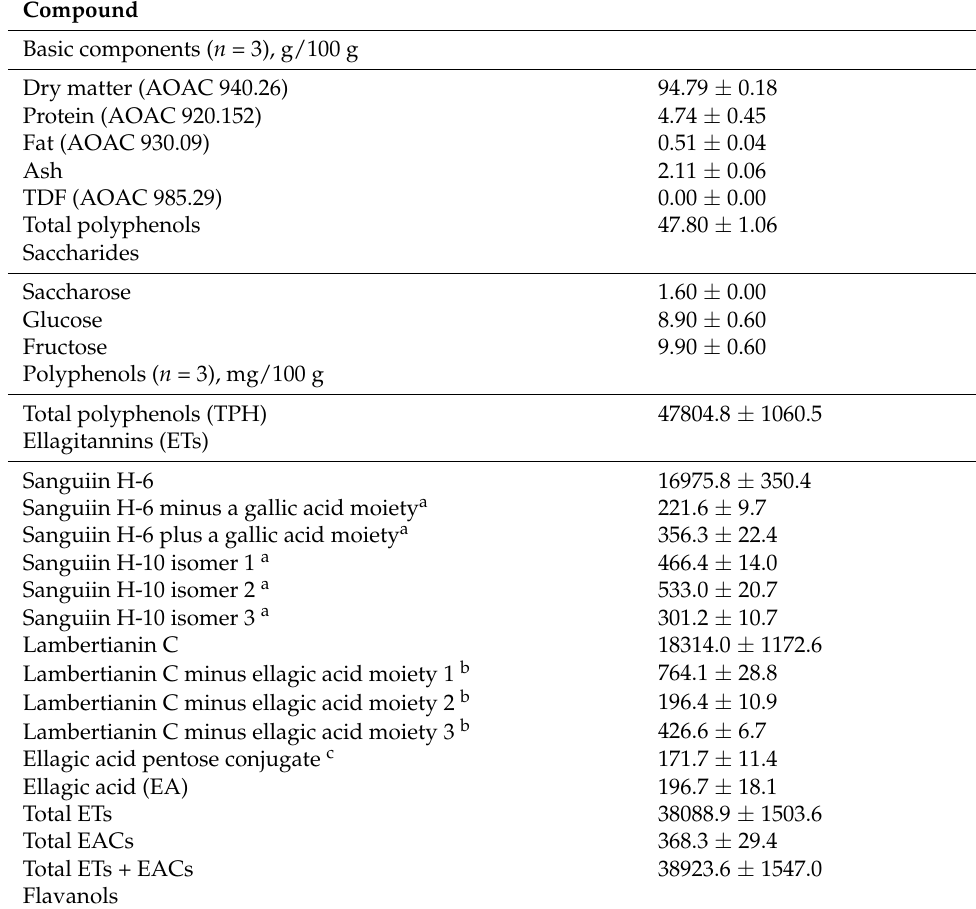
Table 1. Chemical composition of the raspberry polyphenol extract. Compound Basic components ( n = 3), g/100